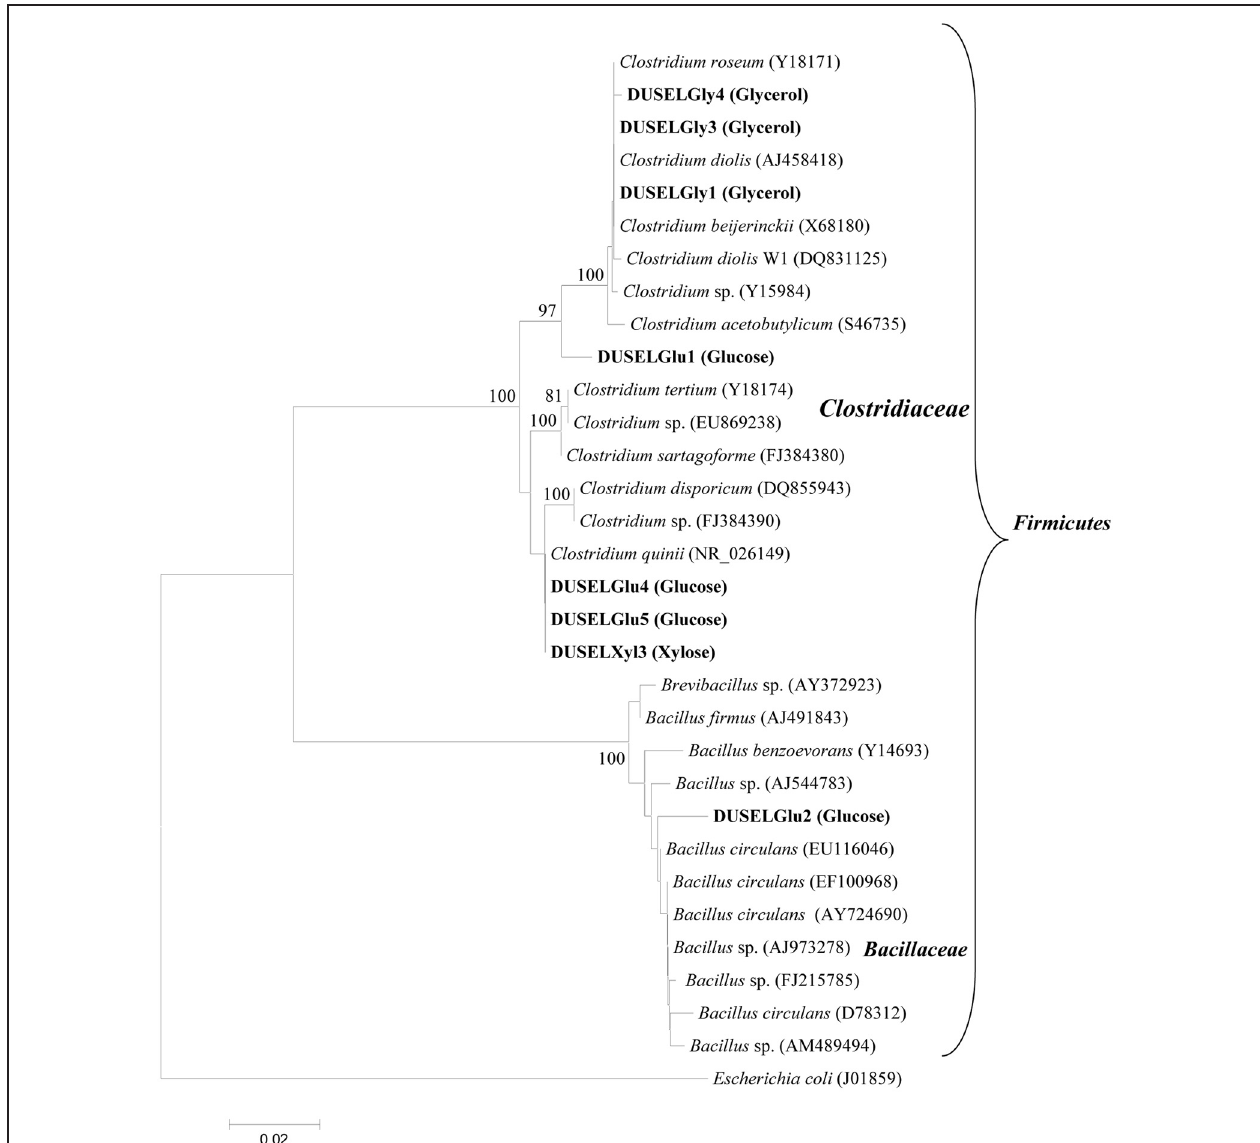
FIGURE 1 | Phylogenetic tree showing the relationship of 16S rRNA gene sequences retrieved from xylose-, glucose-, or glycerol-fermenting DUSEL strains with reference sequences of Clostridium and Bacillus sp. obtained from GenBank. The type of enrichment medium from which a